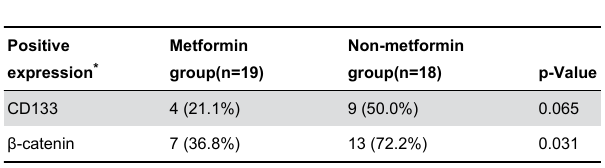
positive; >10% expression of β-catenin in the cytoplasm and nuclei was